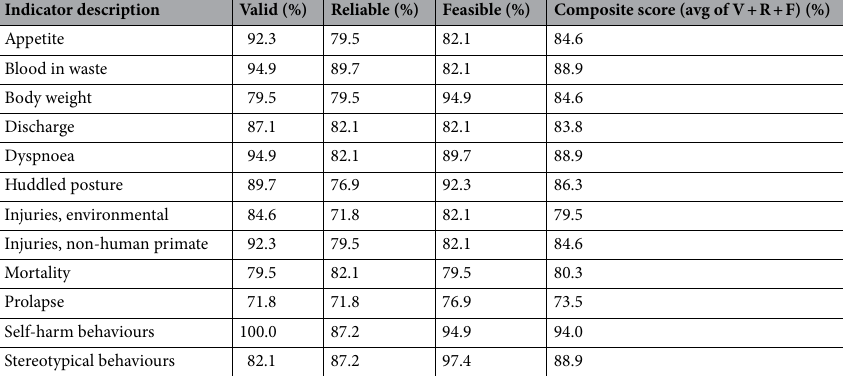
Table 2. Animal-based welfare indicators reaching consensus by percentage agreement